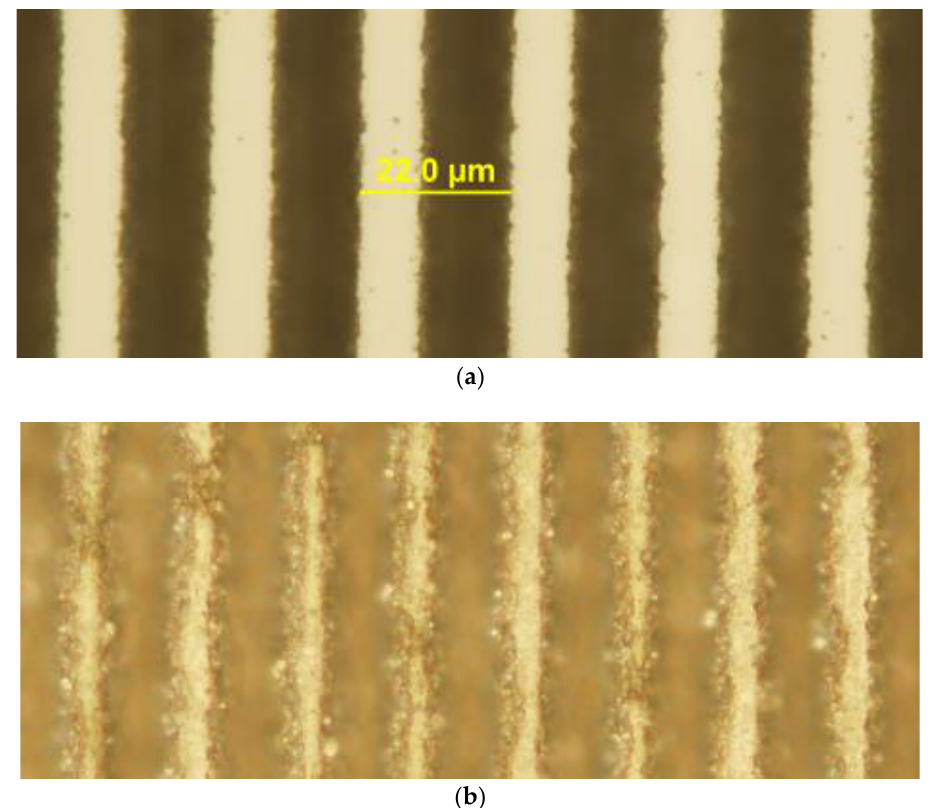
Figure 3. ( a ) Trenches machined in lithium niobate with 6.2 J/cm 2 . The period of the trenches is 22.0 μ m as shown on the scale bar. ( b ) Trenches machined in lithium niobate with 9.5 J/cm 2 .